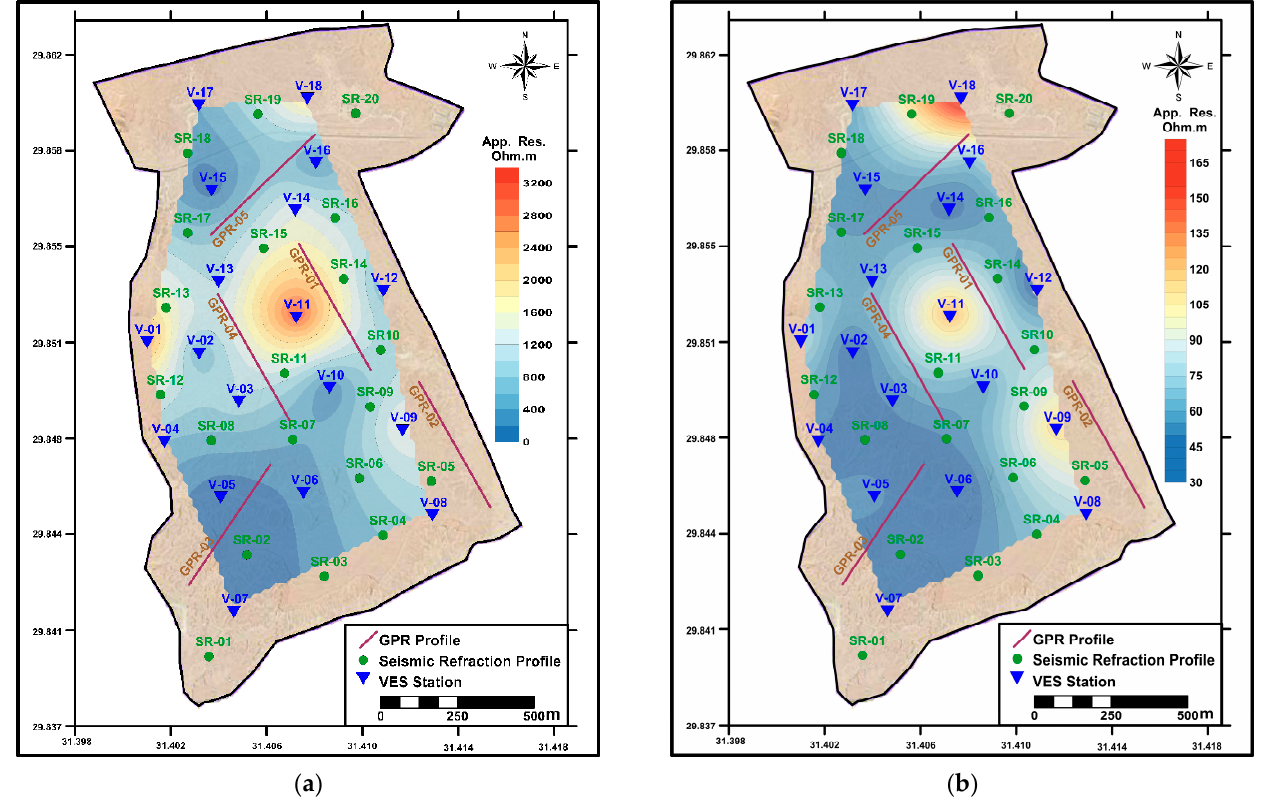
Figure 12. Apparent resistivity contour maps: ( a ) AB/2 = 1 m and ( b ) AB/2 = 30 m.